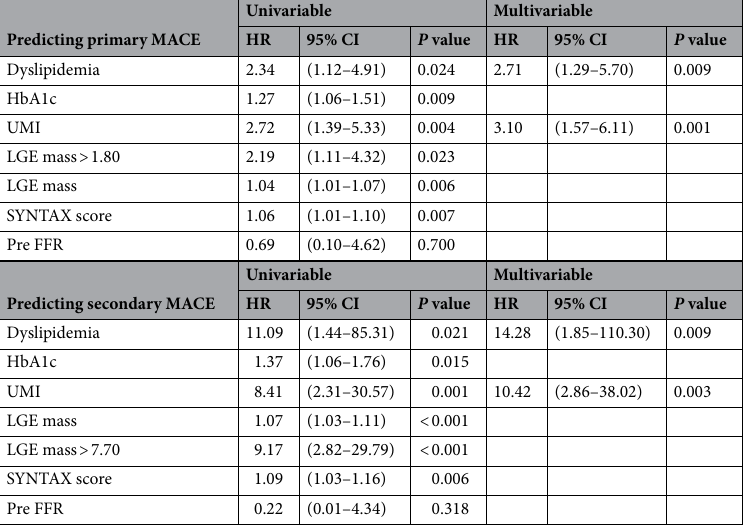
secondary MACE: 7.70 g, area under the curve 0.768, P = 0.001, respectively; Supplementary Figure S2). When patients were divided into two groups based on the best cut-off value of LGE mass, primary and